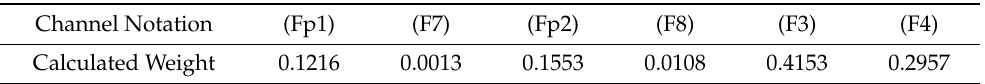
Table 2. The weight values for the different channels in the weighted model after the optimiza- tion process.